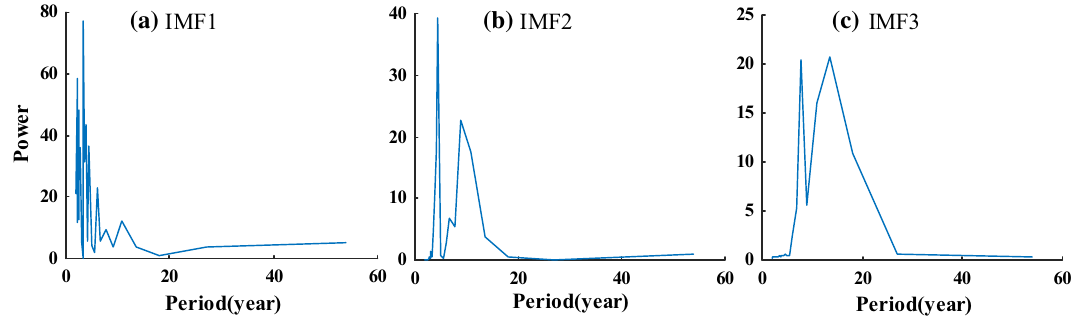
Fig. 4 The power-period graphs of intrinsic mode function (IMF) components of annual scale standardized precipitation evapotranspiration index (SPEI) series in the Heihe River Basin during 1961–2014